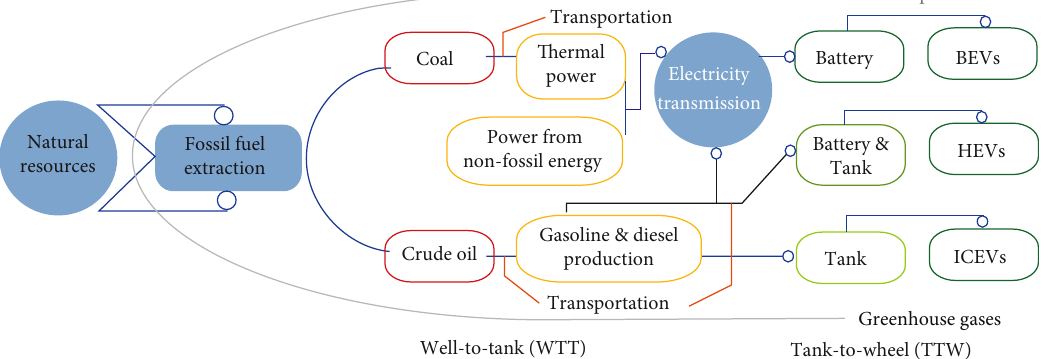
Figure 11: Well-to-wheel system bounder [20].